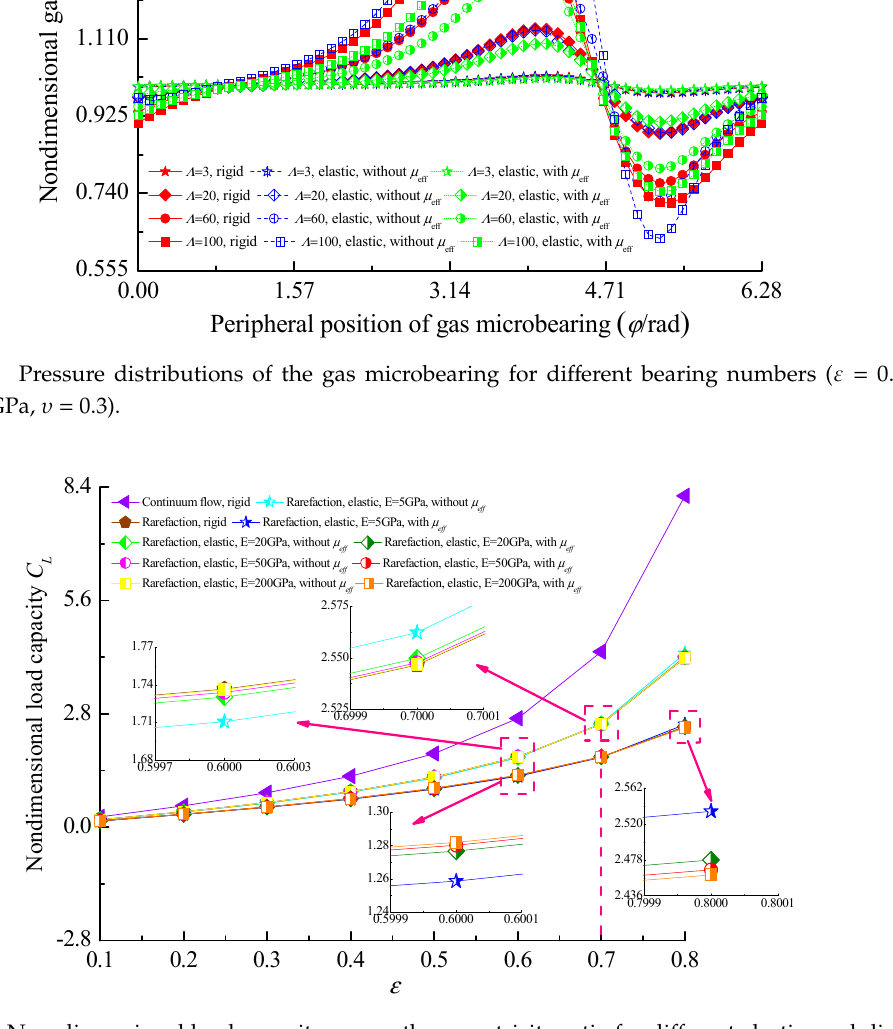
Figure 5. Non-dimensional load capacity versus the eccentricity ratio for different elastic moduli at Λ = 30 and υ = 0.3.